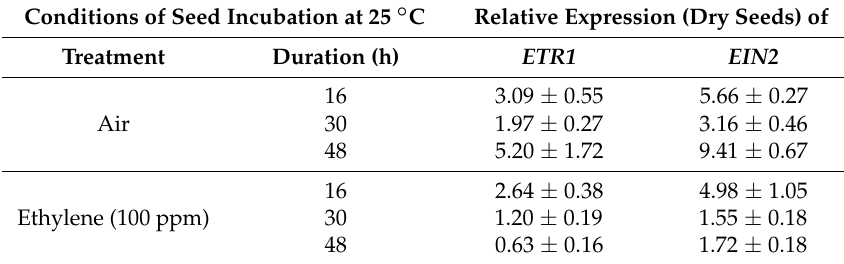
Table 2. Relative expression of ETR1 and EIN2 in seeds (Col-0) incubated for 16, 30, and 48 h at 25 ◦ C in the absence or the presence of ethylene 100 ppm. Calculation was done as compared to dry seeds. Means of three replicates ± SD. Seeds harvested in 2016.